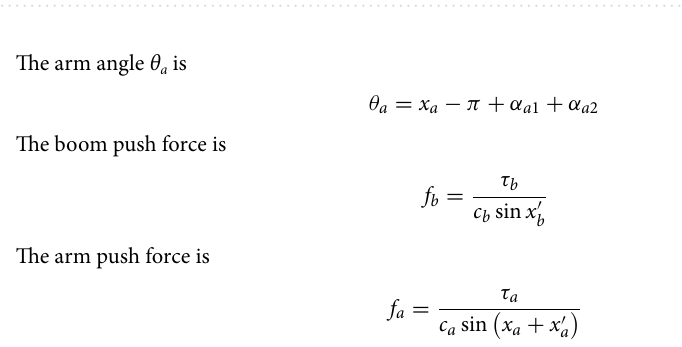
Figure 7. Boom and arm